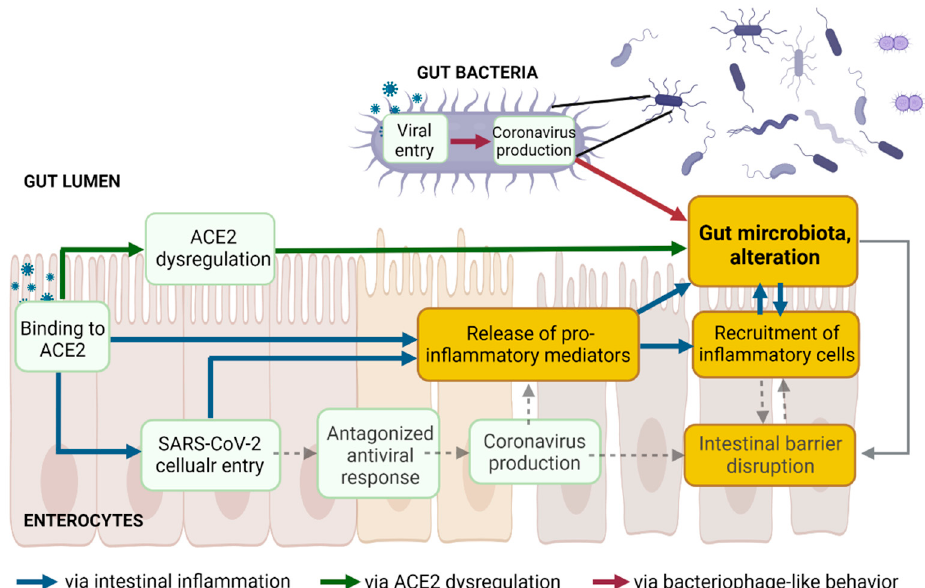
Figure 4. The three proposed pathways leading to gut dysbiosis following SARS-CoV-2 presence in the gut lumen are not mutually exclusive but might be interconnected. Created with